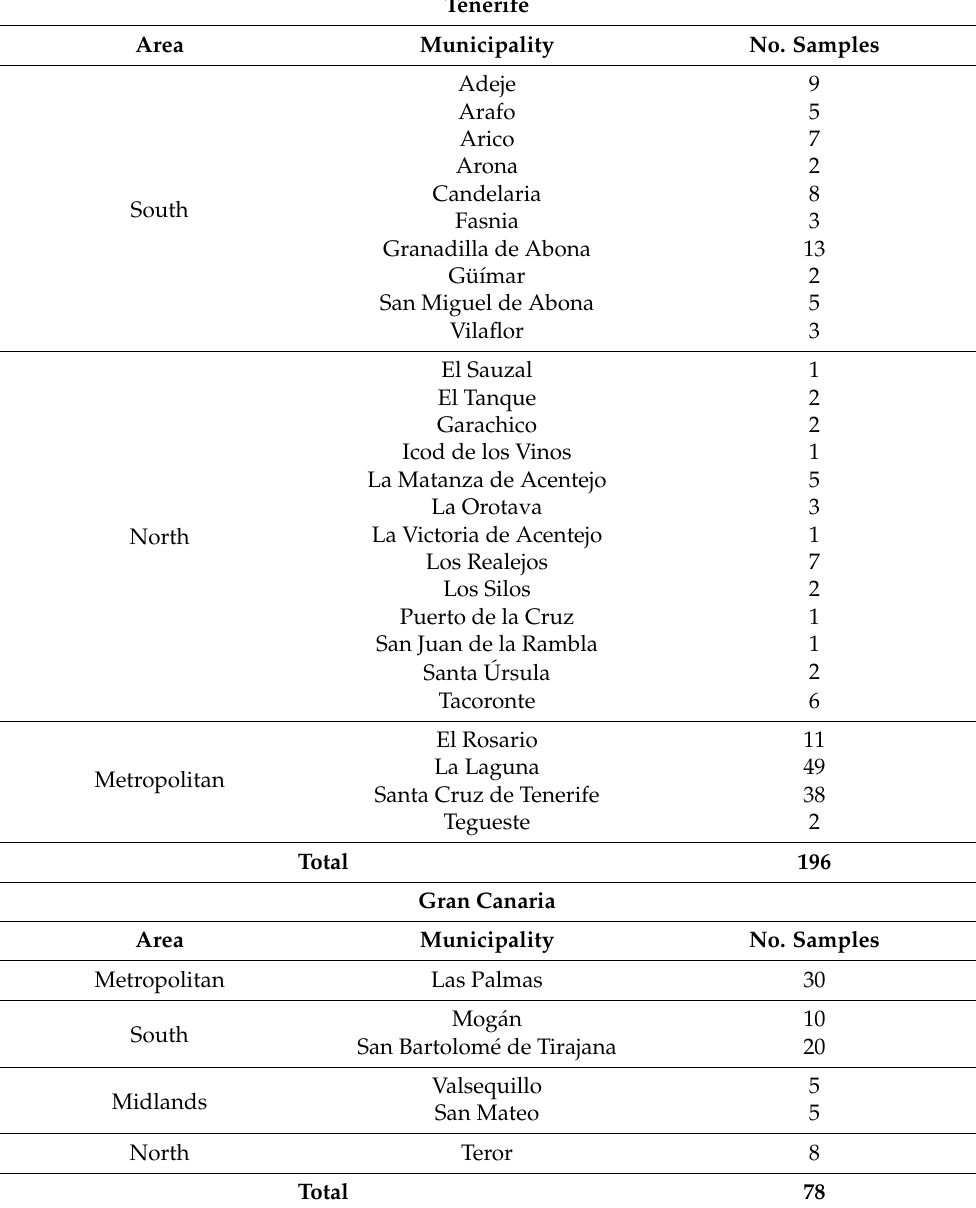
Table 1. Areas sampled on the island of Tenerife and the island of Gran